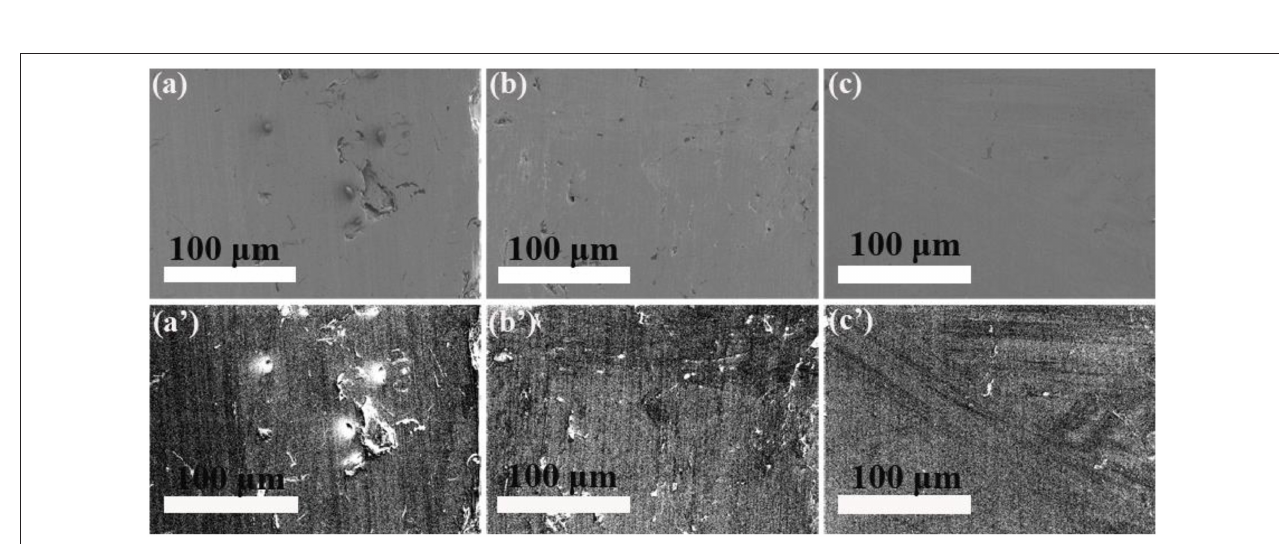
FIGURE 6 | Interface morphologies of NiCrAlY coating and corresponding element maps: (a) as-sprayed, (b) 1,100 ◦ C heat treatment.